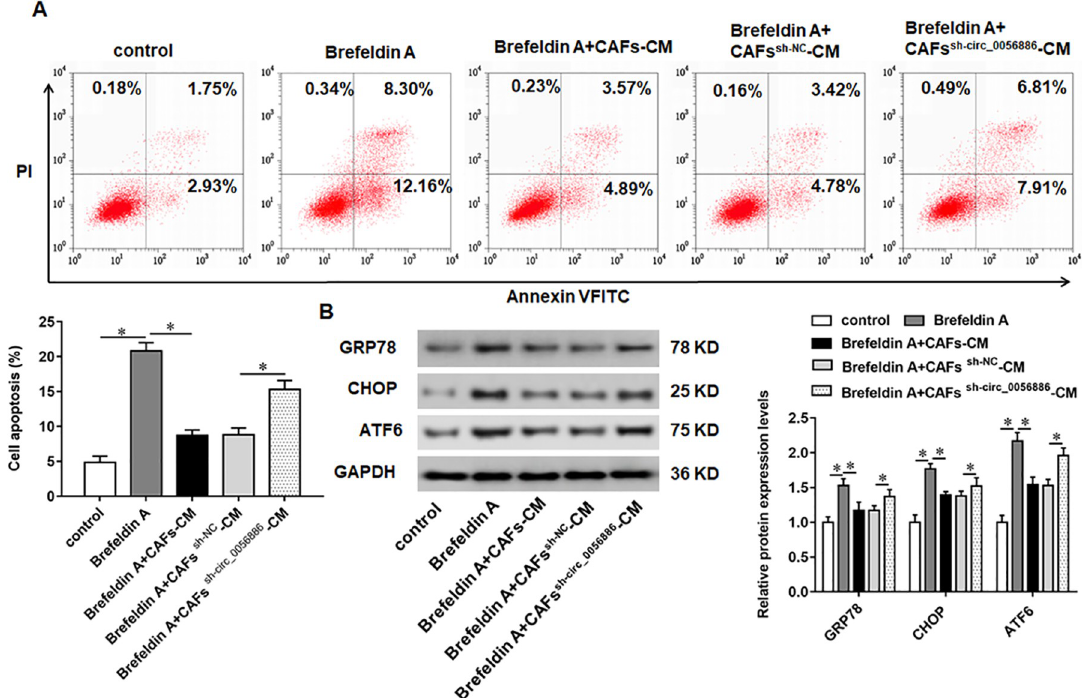
Fig 5. Knockdown of hsa_circ_0056686 reversed the effect of brefeldin A on ERS. LSMCs were treated with brefeldin A (10 mg/mL) alone or together with CAFs-CM or CAFs sh-circ_0056686 -CM. (A) The apoptosis ratio of LSMC was detected by flow cytometry assay. (B) The expression of ERS-related proteins GRP78, CHOP and ATF6 was examined. � P < 0.05, vs control, brefeldin A or brefeldin A + CAFs sh-NC -CM.